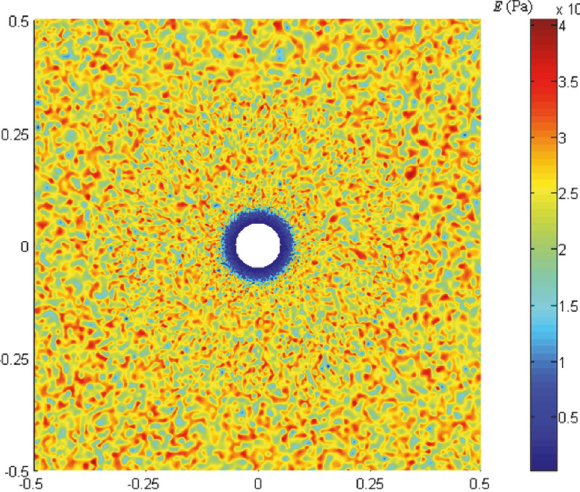
Figure 4: Numerical model of gas seepage process of borehole surrounding rock.